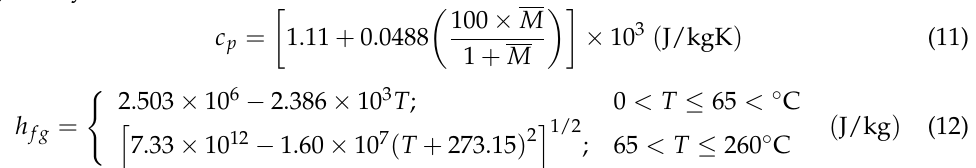
Table 5. Thermal energy data obtained in the experiments. t (min)